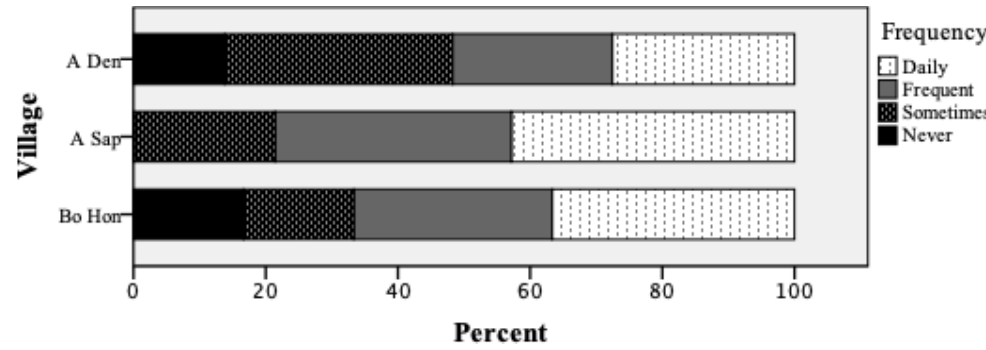
Figure 8. How often households worry about